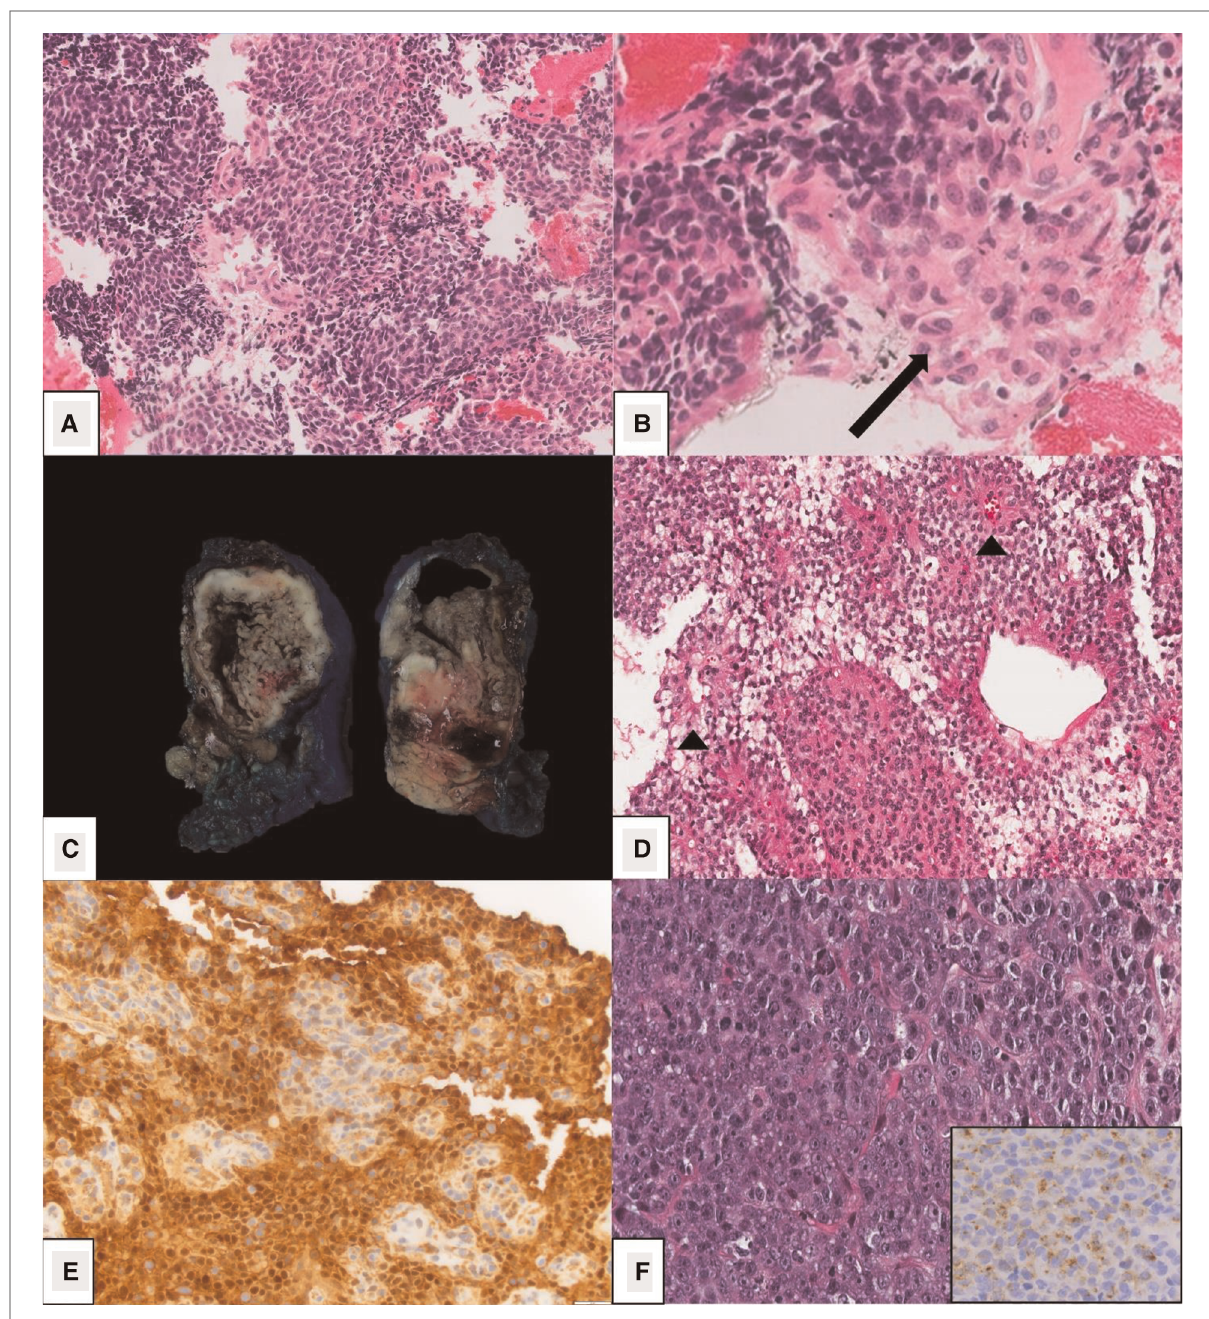
FIGURE 1 Histopathology. ( A-B ) Pancreatoblastoma characterized by rounded cells with eosinophilic cytoplasm and diagnostic squamoid corpuscles (arrow, B) [Picture courtesy: Kathleen Byrnes, MD, Washington University in St. Louis, MO]. ( C-E ) Solid pseudopapillary neoplasm demonstrating a solid and cystic cut-surface ( C ), pseudopapillary structures with central vascular cores ( D ) and nuclear beta-catenin positivity by immunohistochemistry ( E ). ( F ) Acinar cell carcinoma demonstrating a high-grade malignancy composed of round to oval cells with moderate granular amphophilic cytoplasm, prominent nucleoli and positive trypsin